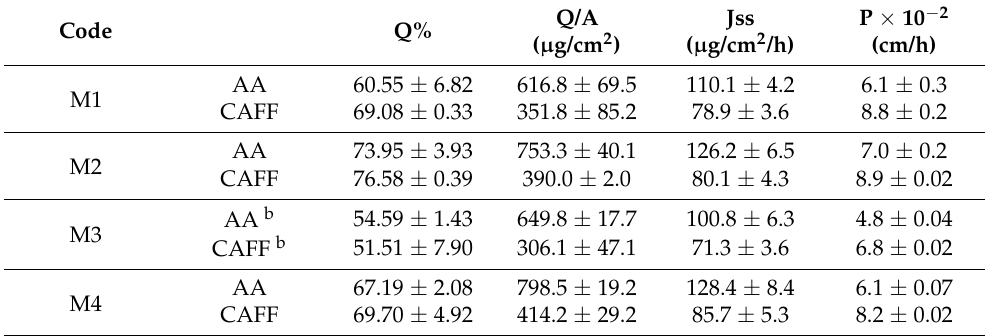
Table 8. Drug permeation parameters from different formulation at 37 ◦ C a .